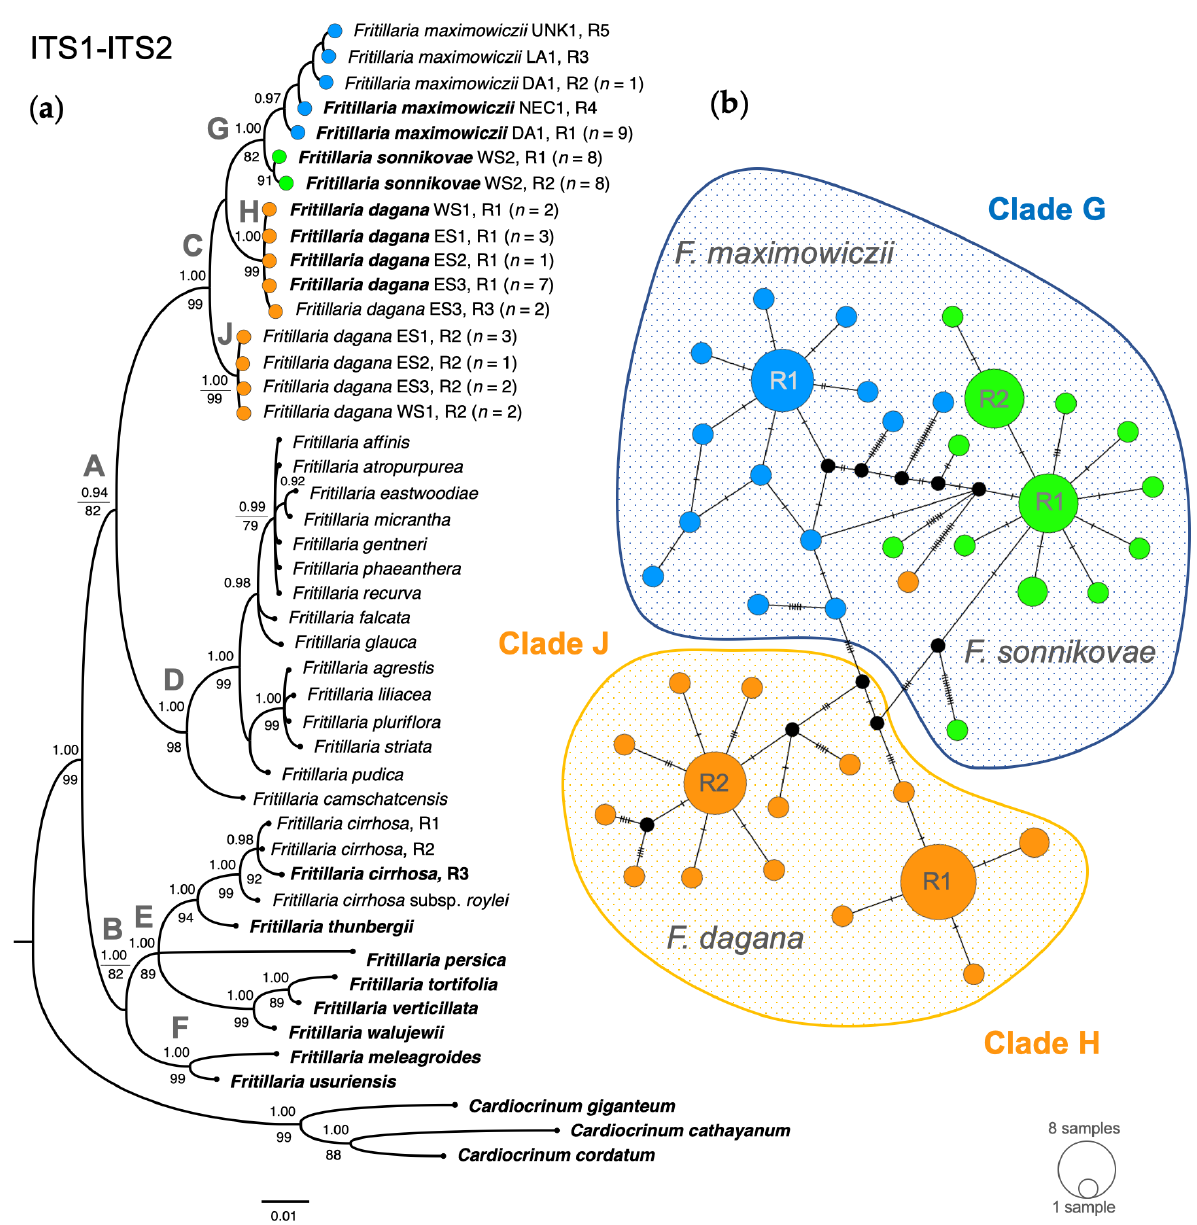
Figure 2. Diversity and phylogenetic relationships between ITS ribotype variants (R) in Fritillaria from different localities. Color patterns and abbreviated names correspond to those in Figure 1 (UNK indicates unknown locality). Capital letters indicate the groups discussed in the text. ( a ) BI phylogram of main ITS ribotypes based on the 50% majority-rule consensus tree. Posterior proba- bilities ≥ 0.90 are indicated above the branches, bootstrap values of the respective clades on the ML tree ≥ 70, below the branches. The number of ribotype copies found by molecular cloning is indi- cated in brackets next to the branch names. ITS variants used in the subsequent joint ITS + ptDNA analysis are indicated in bold. Scale bar represents the number of expected changes (substitutions and/or indels) per site corresponding to the unit of branch length; ( b ) TCS network based on multi- ple ITS variants identified by molecular cloning. Different ribotypes are presented as colored circles connected by lines, where hatch marks correspond to the number of evolutionary events (substitu- tions/indels). Circle size corresponds to the number of identical ribotypes sampled (see the circular scale). Unidentified dark dots show network vertices.